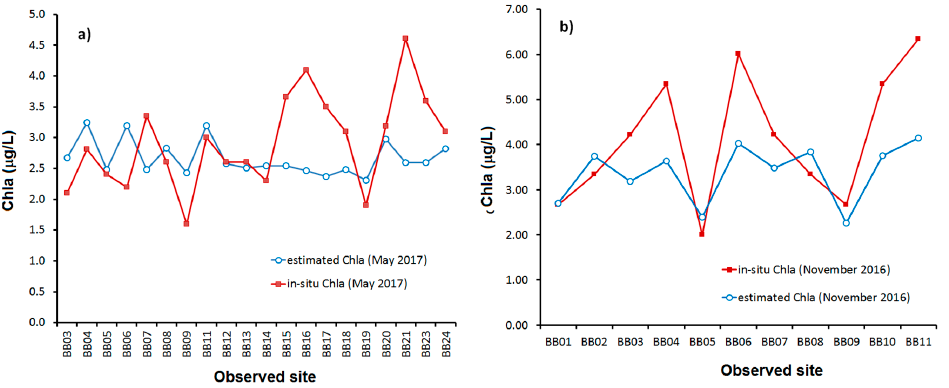
Figure 6. Comparisons between in situ Chla and: ( a ) estimated Chla using Equation (4) and the S2A image acquired on 4 May 2017; and ( b ) the estimated Chla using Equation (4) and the S2A image acquired on 5 November 2016.